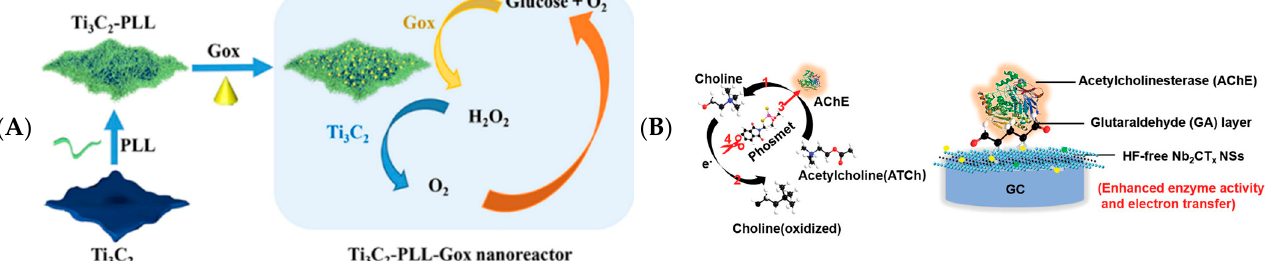
Figure 6. ( A ) Schematic diagram of the detection of the Ti 3 C 2 -PLL-Gox nanoreactor Reprinted with permission from Ref. [56]. Copyright 2020, Elsevier. ( B ) Schematic illustration of the enzymatic inhibition of sulfoxide detection by the HF-free Nb 2 CT x /AChE biosensor Reprinted with permission from Ref. [26]. Copyright 2020, Wiley-VCH.